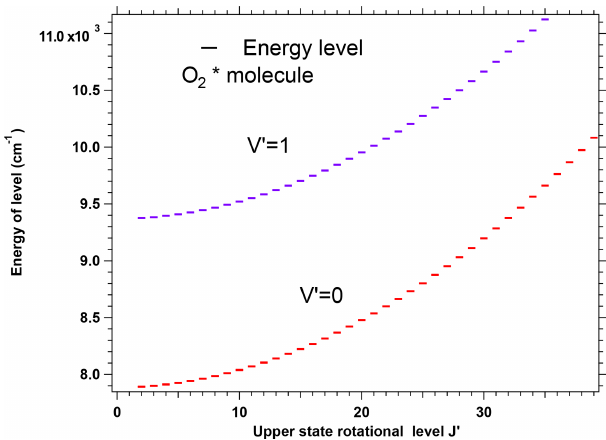
Figure A3. Energy levels (in cm − 1 ) of the excited molecule O 2 * as a function of rotational and vibrational quantum numbers J (cid:48) and V (cid:48) . At LTE and atmospheric temperatures, Q up Q tot (T ) with a factor Q approximately between 0.1 and